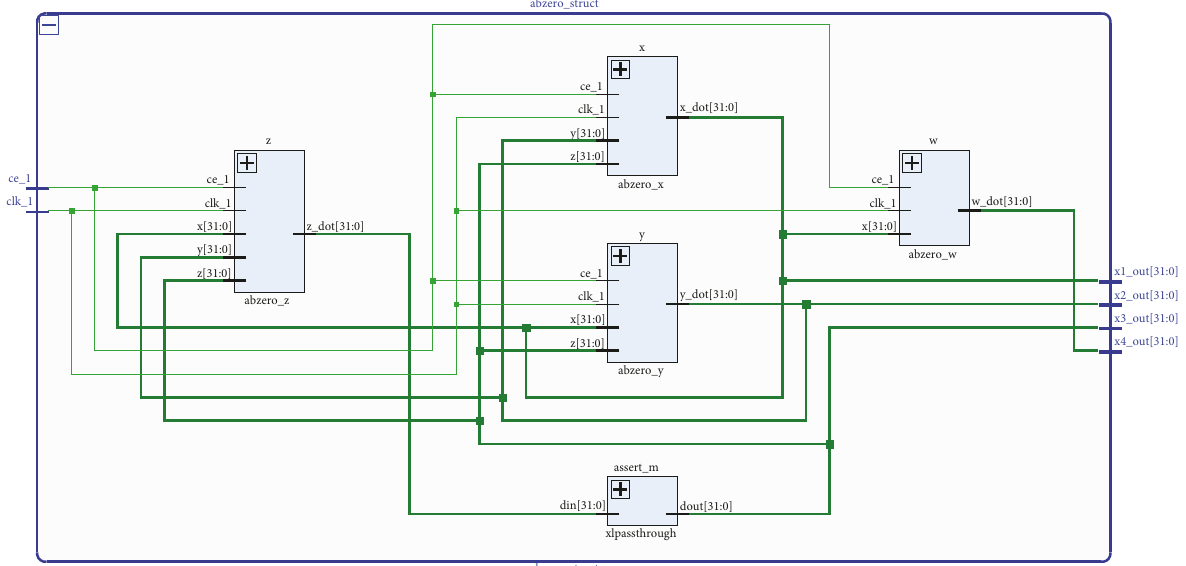
Figure 23: RTL schematics of FONCS-3